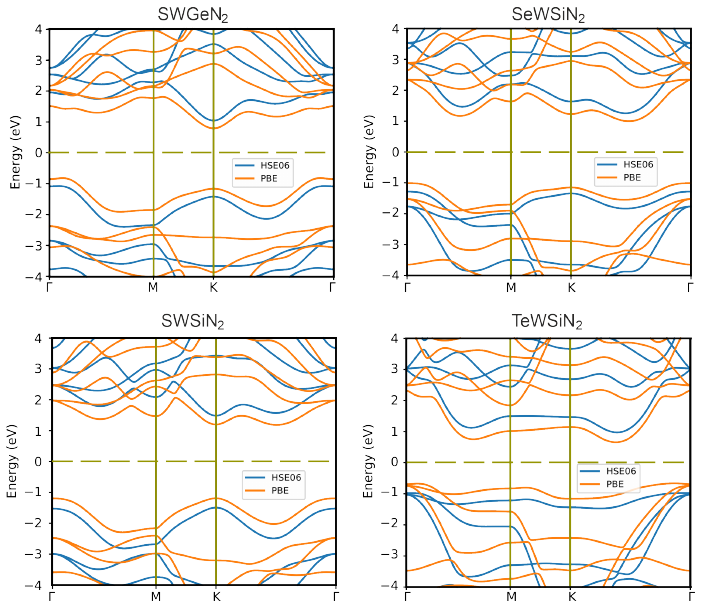
Figure 3. Band structures of 2D XMoSiN 2 (X = S, Se, Te) calculated using PBE (orange lines) and HSE06 (blue lines) functionals. The dashed line represents the Fermi level.